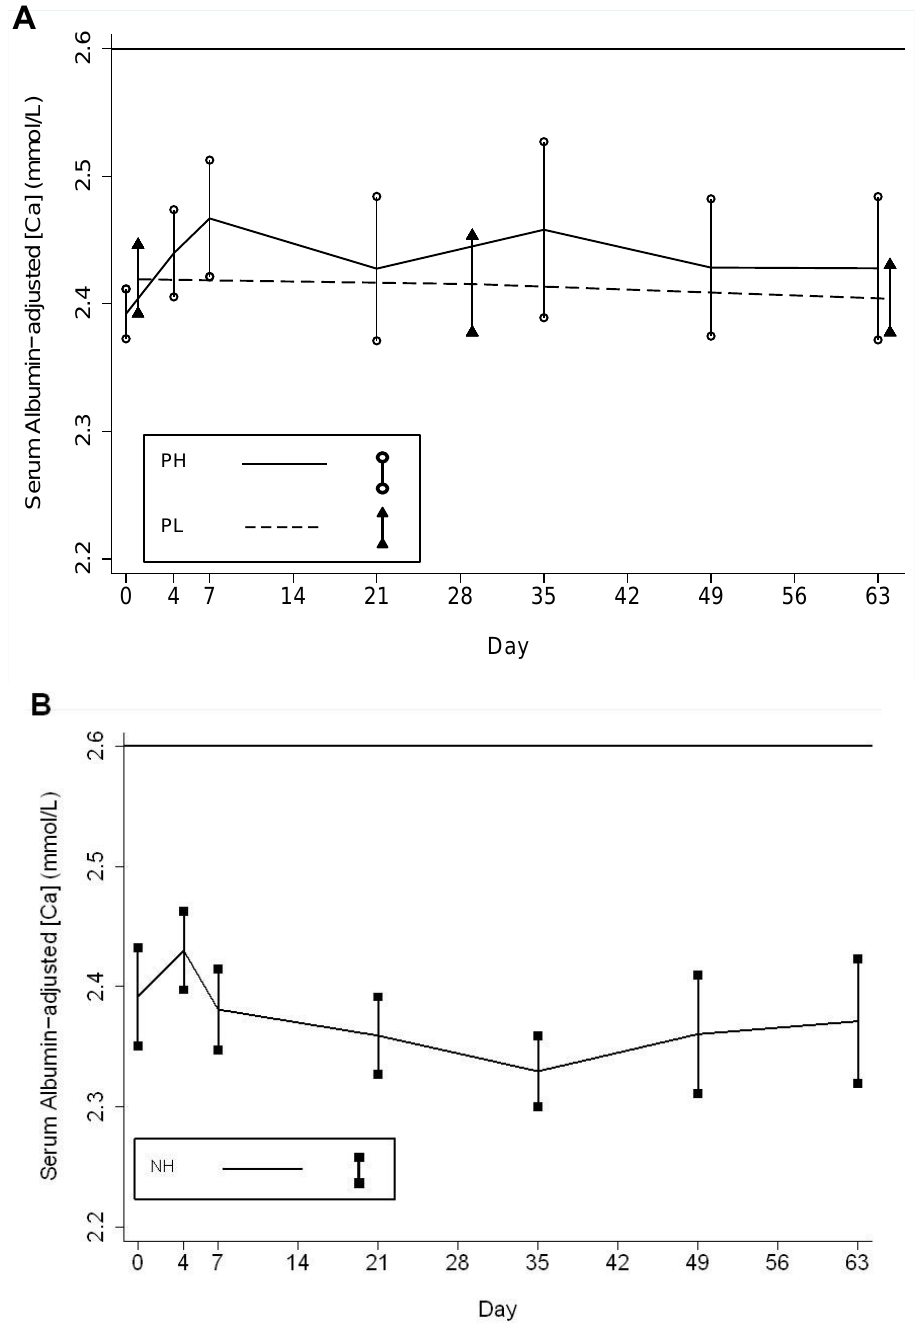
Figure 6. Mean albumin-adjusted serum calcium concentrations in the three participant groups. ( A ) Mean albumin-adjusted serum calcium concentration in pregnant participants who received an initial dose of 70,000 IU and then 35,000 IU/week (PH) and pregnant participants who received a weekly dose of 14,000 IU/week (PL); ( B ) Mean albumin-adjusted serum calcium concentration in non-pregnant participants who received an initial dose of 70,000 IU and then 35,000 IU/week (NH). Vertical bars represent the 95% confidence intervals of the means at each scheduled follow-up time. Horizontal line indicates the upper limit of the reference range (2.60